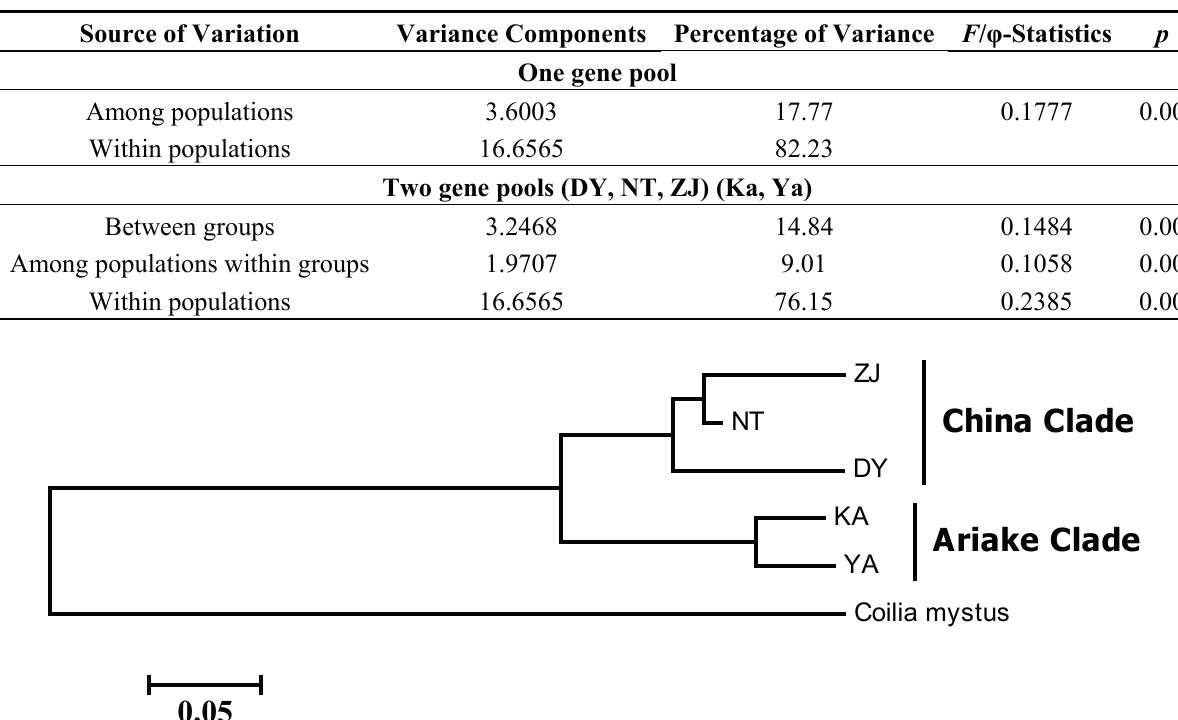
Figure 1. Spatial genetic structure according to a Bayesian assignment probability analysis using the program STRUCTURE 2.3. K = 2 appeared to be the optimal number of clusters by showing the Δ K at its peak. Table 3. Analysis of molecular variance (AMOVA) based on the AFLP markers.